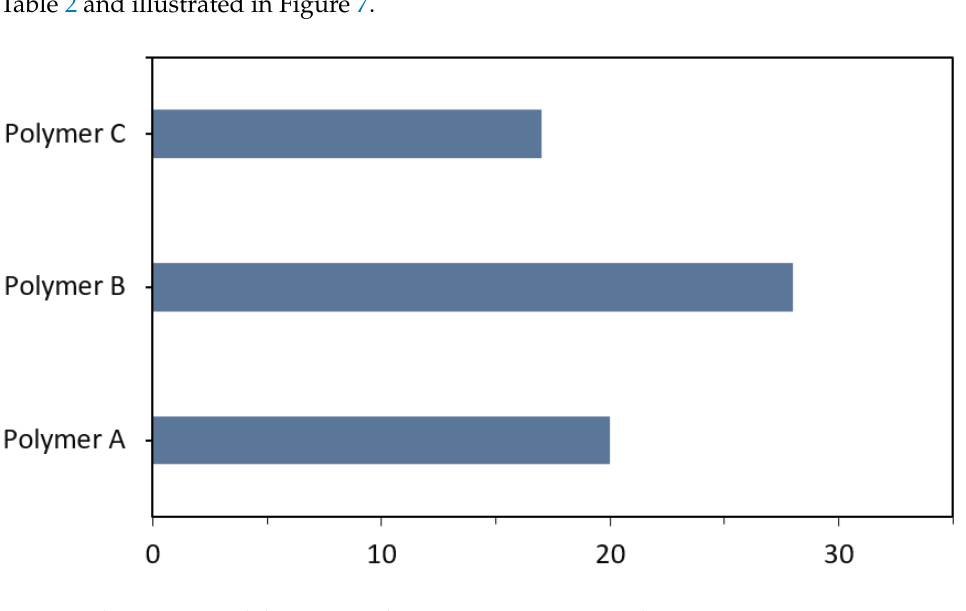
Figure 6. Photographs of peel strips after completing two peel strength tests on all three polymers. In the case of polymer B, peel strip photographs show large clumps and some bare patches without gel, indicating a weaker adherence to the hydrophilic paper surface (Figure 6 — Polymer B). This indicates that the inherent gel particle size of gel B was larger and that the coating was not as uniform as that of gel A. No difference was observed between the peel strength test results of polymers B and C (Figure 6).